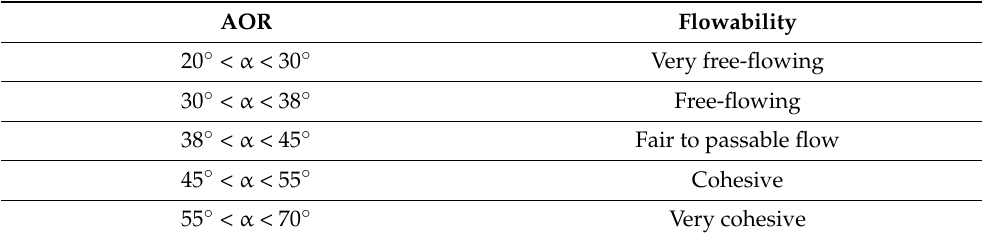
Figure 1. The WC-17Co powders: ( a ) The morphology, ( b ) the particle size distribution. Table 1. Classification of flowability by the AOR.